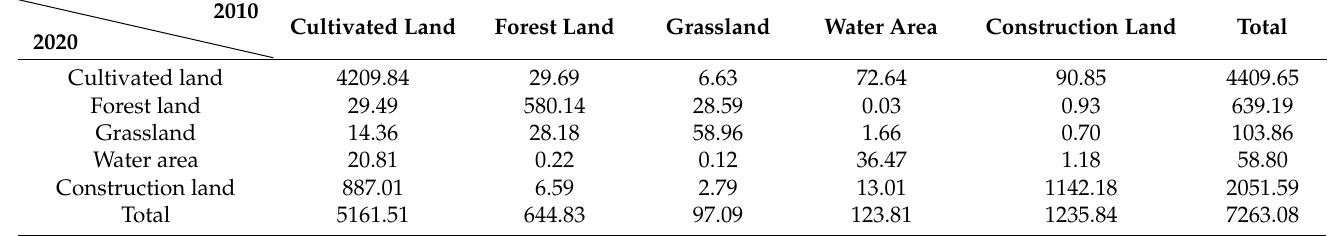
Table 13. The land use transfer matrix in Zhengzhou from 2010 to 2020 (unit: km 2